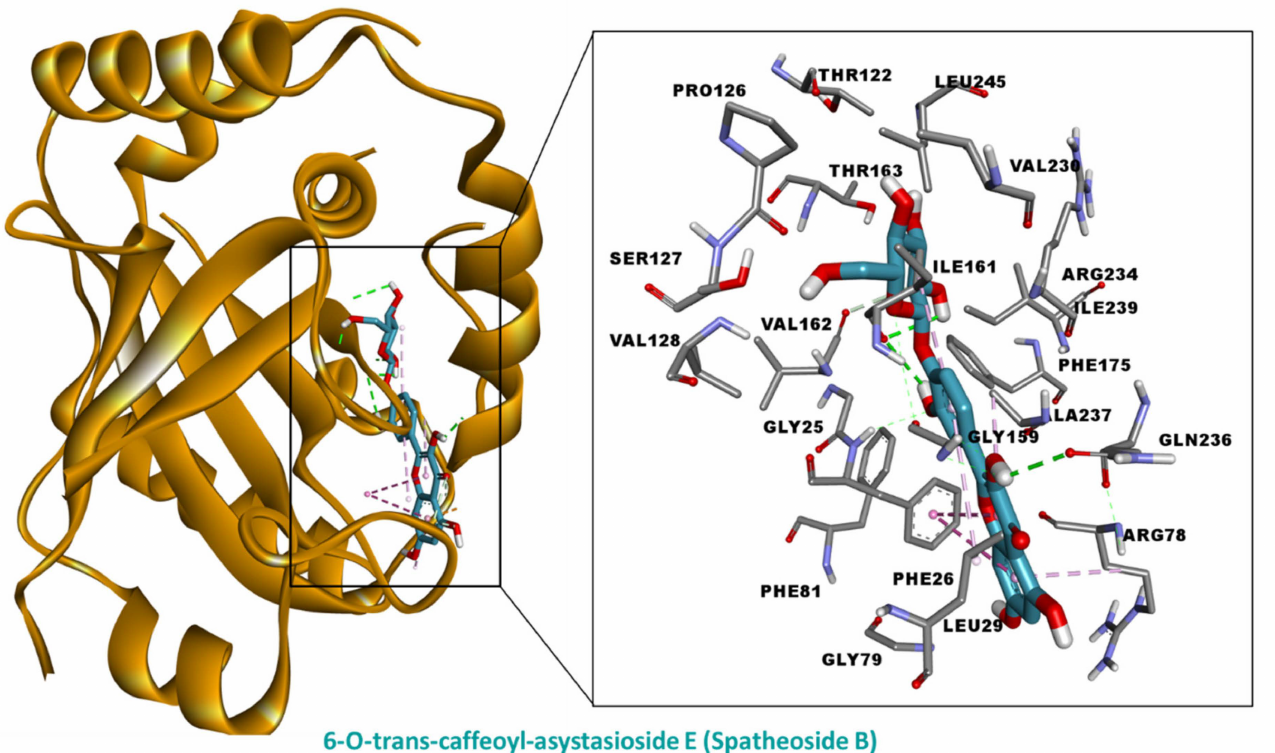
Figure 9. Interaction between HSV-1 protease and 6- O -trans-caffeoyl-asystasioside E (spatheoside